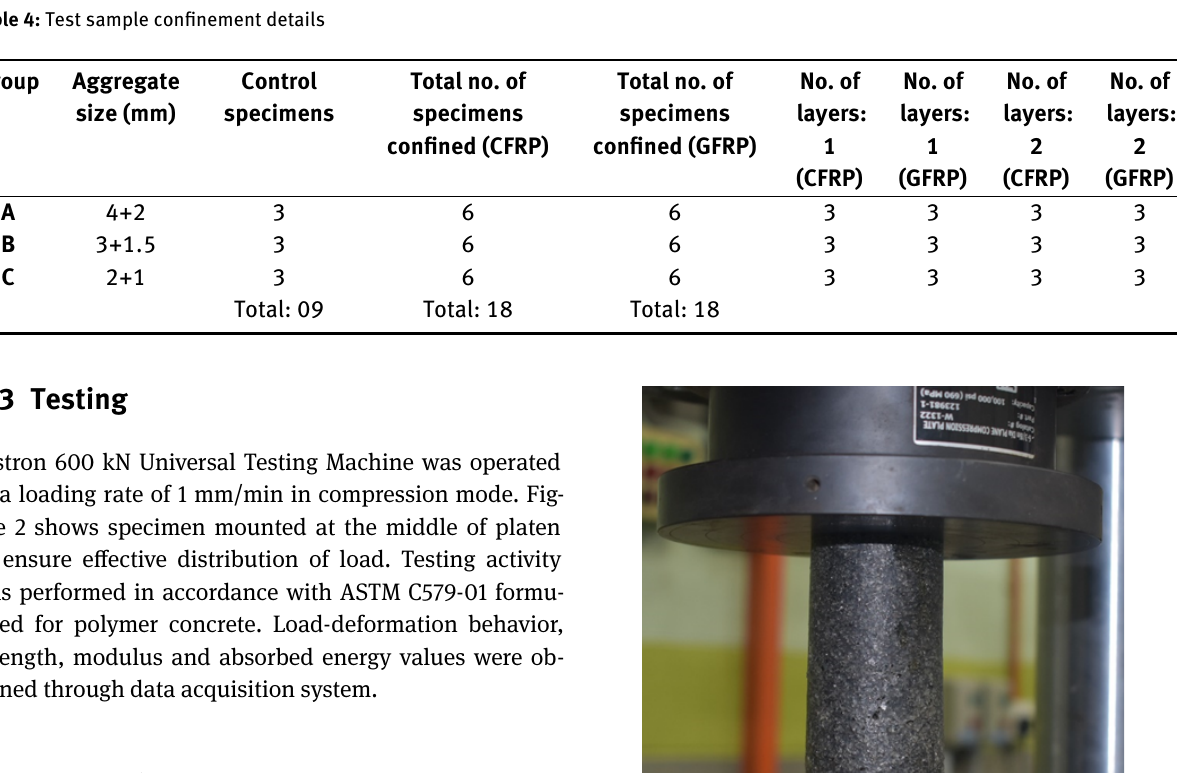
Table 4: Test sample confinement details